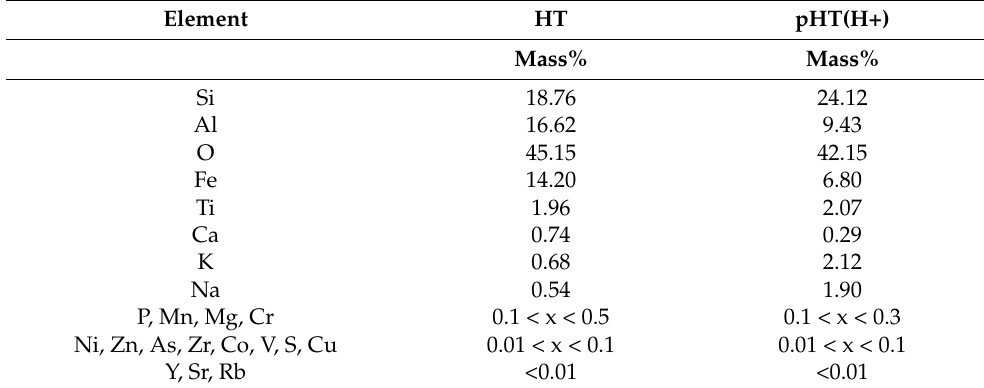
Table 1. Chemical elemental composition of raw halloysite and the precipitate after acid treatment measured by